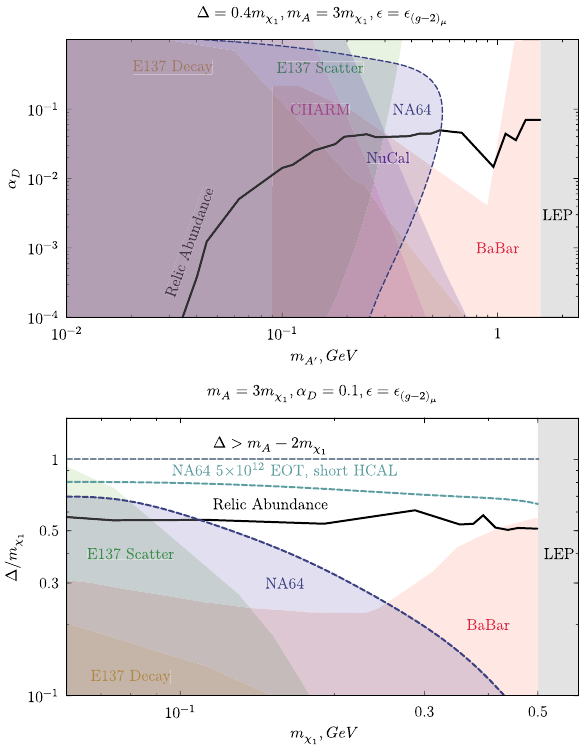
Fig. 5 The NA64 90% exclusion limit for a new vector boson A (cid:2) with a coupling to electrons with decay mode A (cid:2) → χ 1 χ 2 (χ 2 → χ 1 e + e − ) . The limits were derived in the ( m A (cid:2) ; α D ) (top) and ( m χ (bottom) plane assuming α D = 0 . 1, m A (cid:2) = 3 · m χ where ε ( g μ − 2 )/ 2 is the value in the central band of the ( g μ − 2 )/ 2 anomaly.ConstraintsfromBabarandE137arealsoshownfollowingthe recasting done in Refs. [14,15], together with the bounds of NuCal and CHARM [37]. A thick black line shows the combination of parameters compatible with a DM thermal relic scenario. The projected limit for 5 × 10 12 EOT using a compact HCAL1 are drawn in the ( m χ Δ/ m χ ) 1